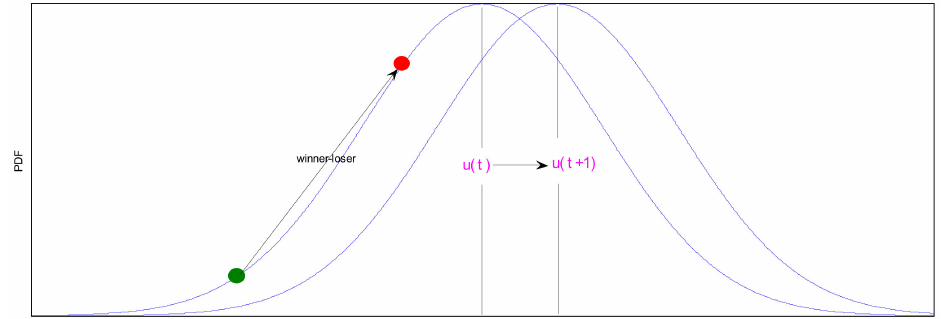
Figure 4. The interpretation for updating rule with winner and loser